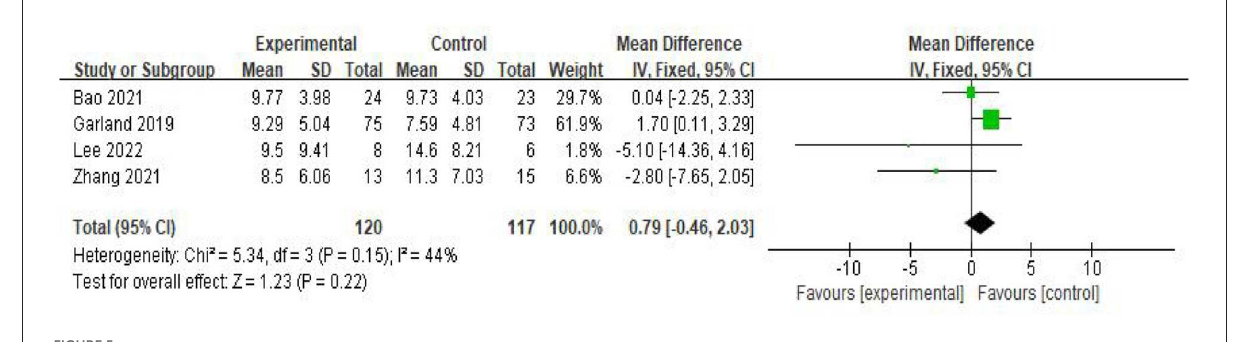
FIGURE5 Forest plot of ISI scale scores.